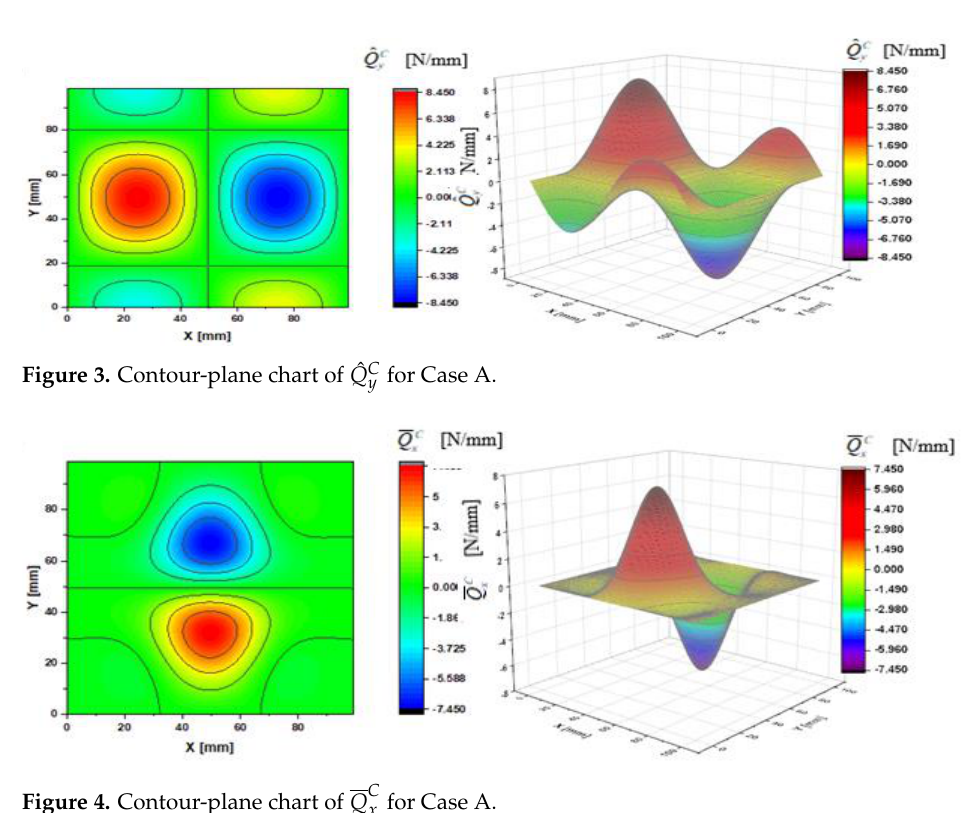
Q ˆ for Case A. x Q ˆ for Case A. Q ˆ for Case A. x x